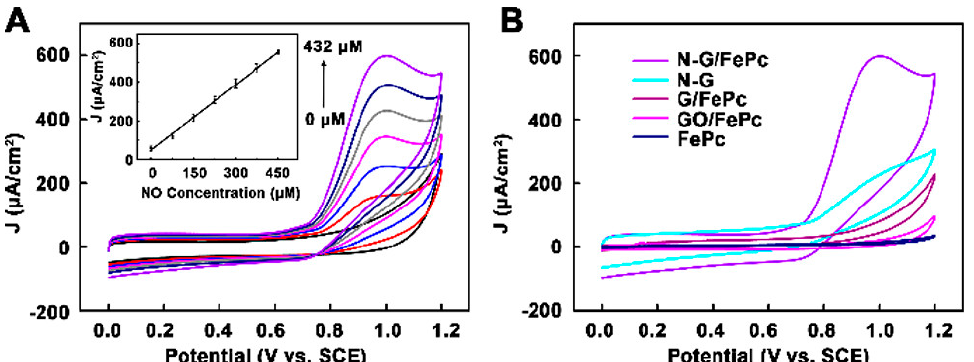
Figure 8. ( A ) CV of N-G/FePc/Nafion/PLL ITO electrode in 0.01 M PBS (pH 7.4) containing various